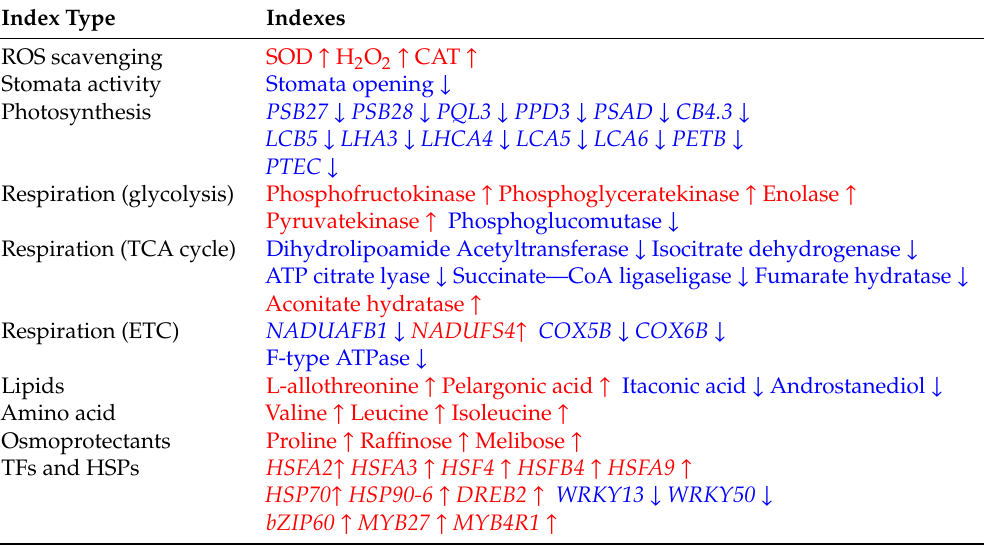
Table 1. Summary of responses in P. tomentosa subjected to heat